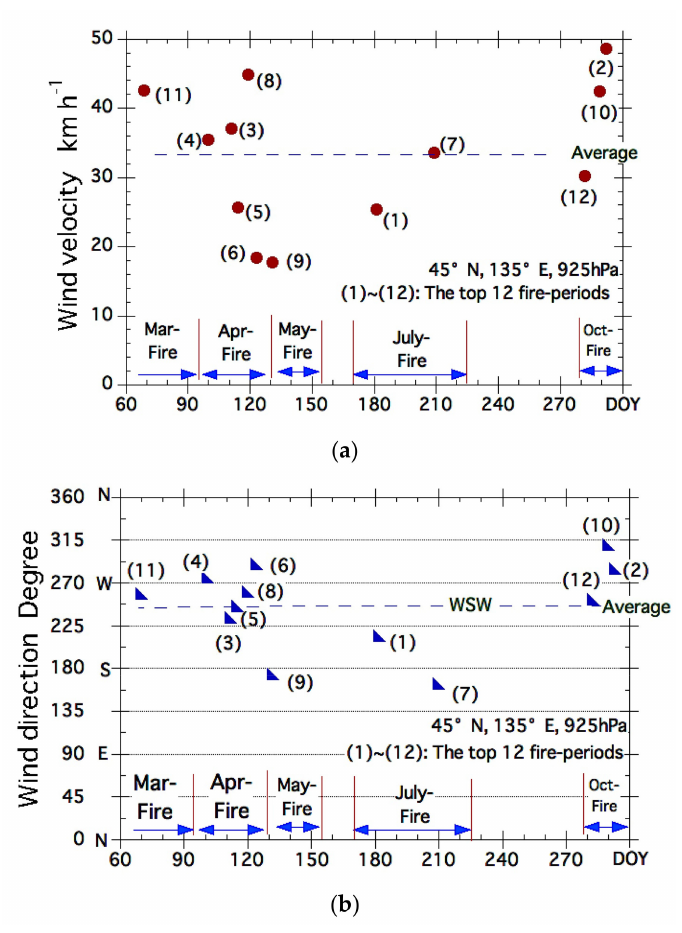
Figure 10. Wind conditions at the lower-level (925 hPa) for the top 12 active fire-periods. ( a ) Wind velocity; ( b ) Wind